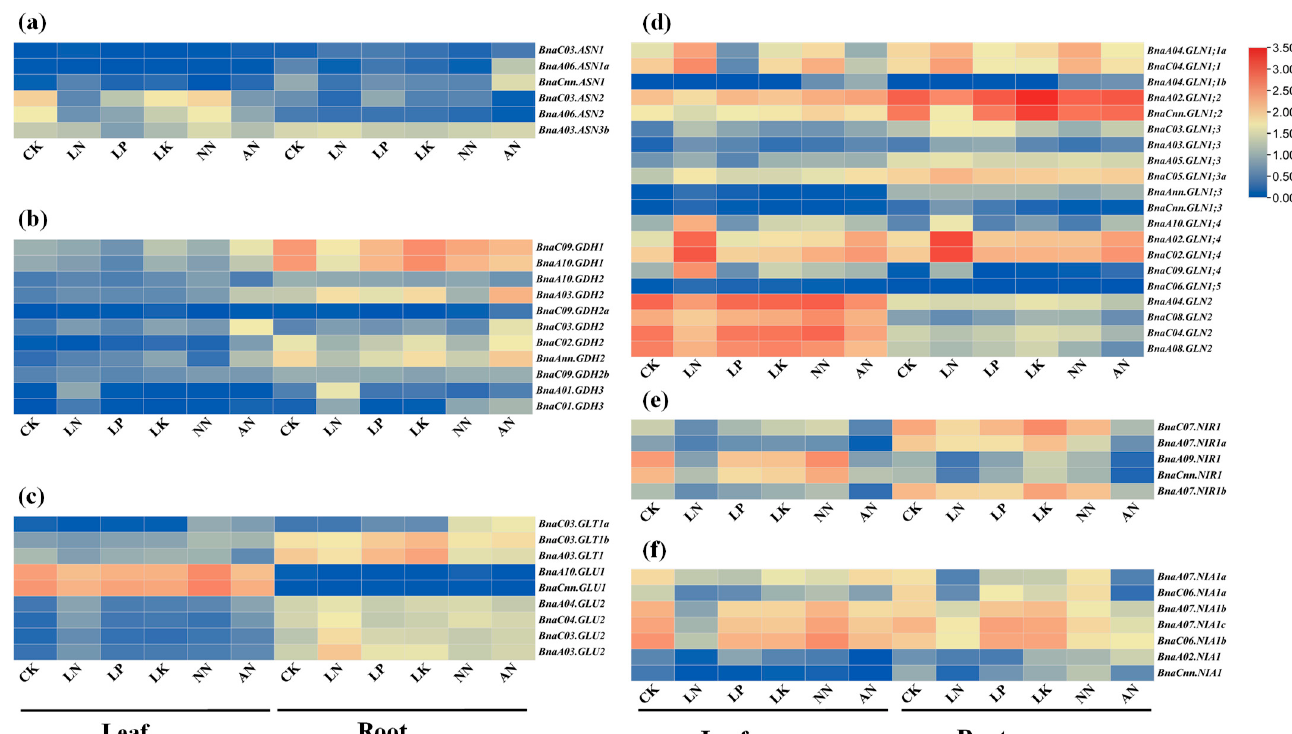
Figure 6. Expression profiles of the genes involved in nitrogen (N) assimilation in leaf and root of Brassica napus under N, phosphorus (P), potassium (K) deficiencies and ammonium (NH 4+ ) toxicity. ( a ) The AS family genes; ( b ) The GDH family genes; ( c ) The GOGAT family genes; ( d ) The GS family genes; ( e ) The NiR family genes; ( f ) The NR family genes. For nutrient starvation treatments, 14-day-old seedlings were exposed to nutrient solution free of N, P and K for seven days. For the NH 4+ toxicity treatments, 14-day-old seedlings were treated with nutrient solution containing 6 mM NH 4 Cl or 6 mM NaNO 3 (control) for nine days. The fully expanded leaf and root were sampled separately for RNA-seq analysis. CK, sufficient nutrient supply. LN, N deficiency. LP, P deficiency. LK, K deficiency. NN, NO 3 − -N. AN, NH 4+ -N. The colored scale was shown on the right side. Heat maps of gene expression profiles were generated using TBtools after data normalization